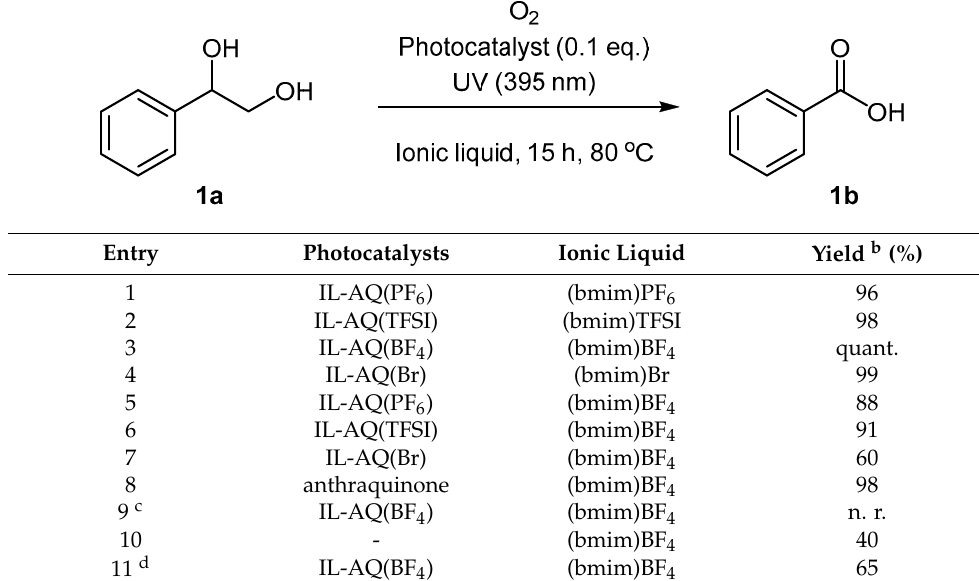
Table 1. Optimization of the reaction conditions a . a Condition:1-phenylethane-1,2-diol (0.3 mmol), photocatalyst (0.03 mmol), ionic liquid (3 mL), 80 ◦ C, 15 h. b Isolated yield. c In the dark. d Amount of photocatalyst is 0.01 eq.